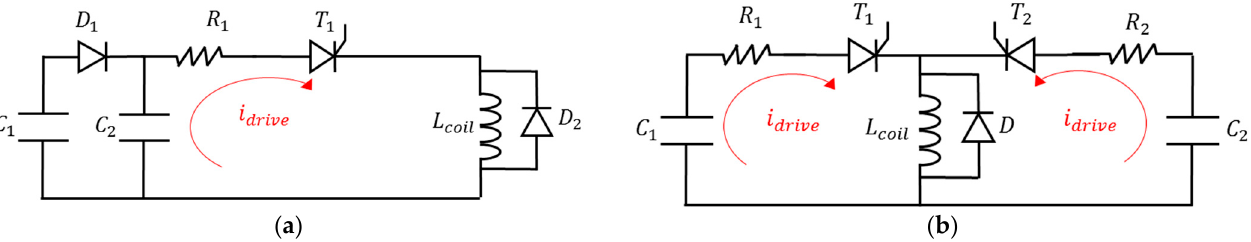
Figure 12. Multiple pulse control circuits of TCA; ( a ) two-stage pulse circuit; ( b ) pulse-forming drive circuit